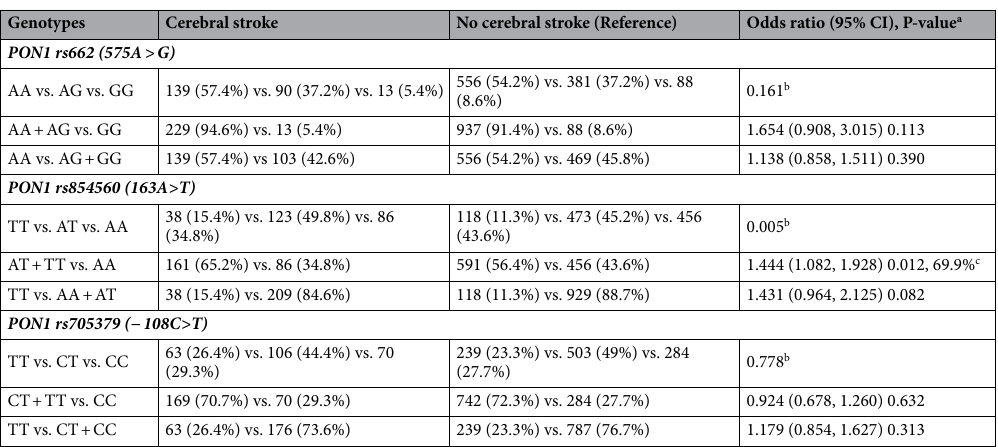
dyslipidaemia (and the TG/HDL-cholesterol ratio) , as well as appeared for living in rural areas, urine output, and zinc supplementation.